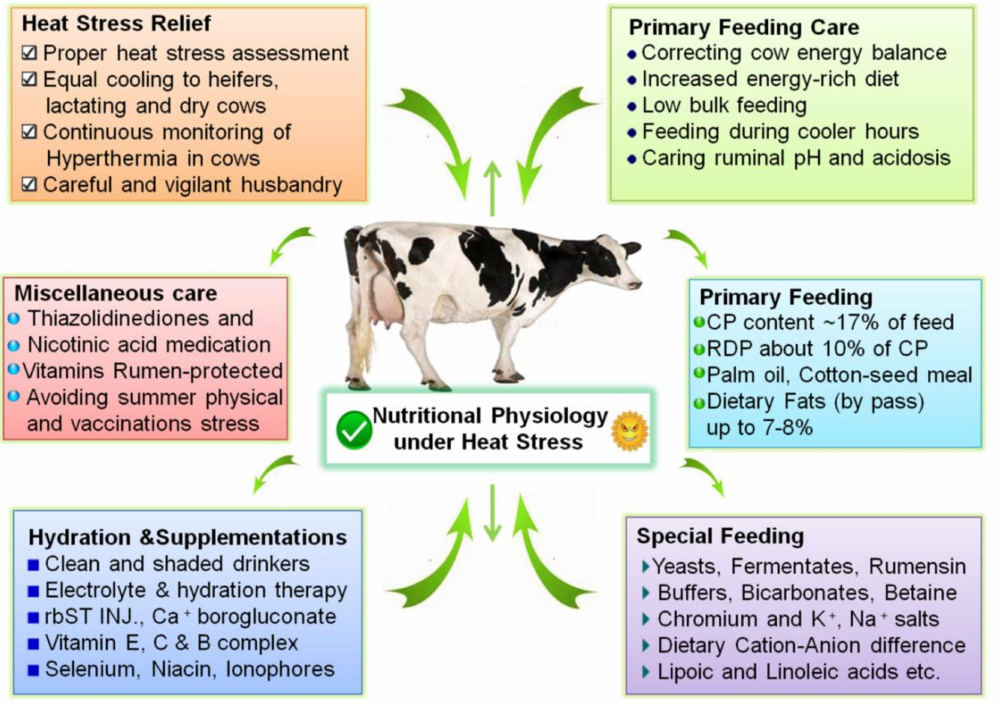
Figure 2. Summary of various impact mitigation strategies to support heat stress-related physiological and biochemical disequilibrium at the various systems-level and improve the production and welfare of dairy cows. (CP = crude protein, RDP = rumen-degradable protein, rbST = recombinant bovine